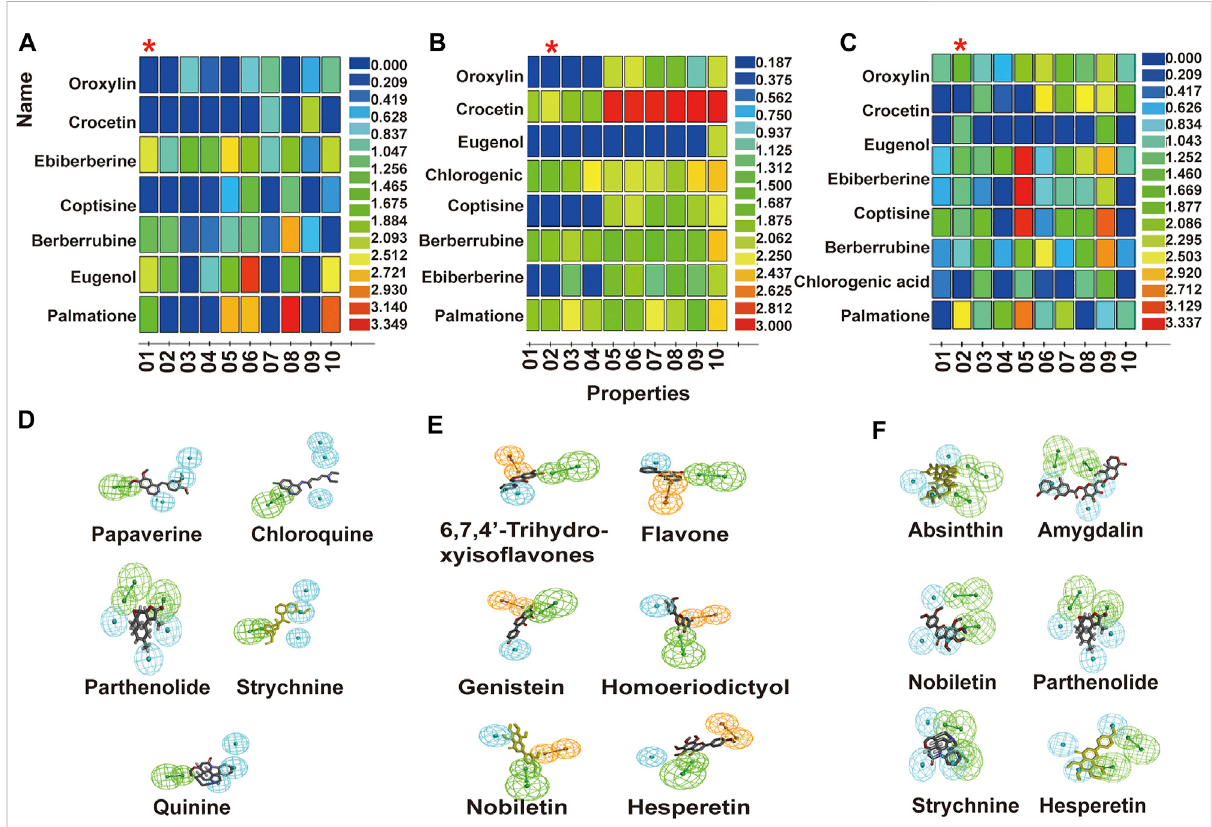
FIGURE 3 Bitter taste activity of pharmacophore predicted test set compounds and matching results of compounds in the training set and optimal pharmacophore. (A,B,C) showthetop10pharmacophoresofTas2r10,Tas2r14,andTas2r46. (D,E,F) showthematchingresultsofcompoundsinthe trainingsetandoptimalpharmacophoreofTas2r10,Tas2r14,andTas2r46.The X -axisrepresentsthepharmacophore(01 – 10representstheorderof the pharmacophore determined using software), and the Y -axis represents the compounds matching the pharmacophore. Blue indicates that the match is zero, and red shows that the matching activity is